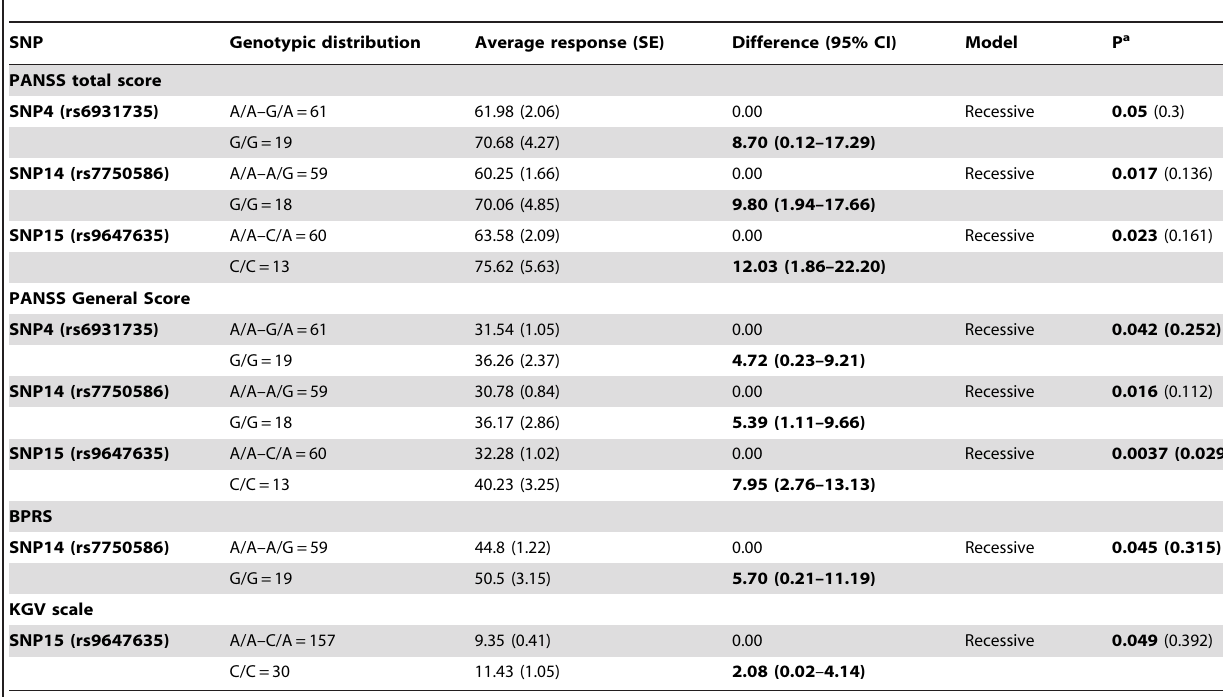
Table 2. AHI1 SNPs significantly associated with clinical traits in the Spanish